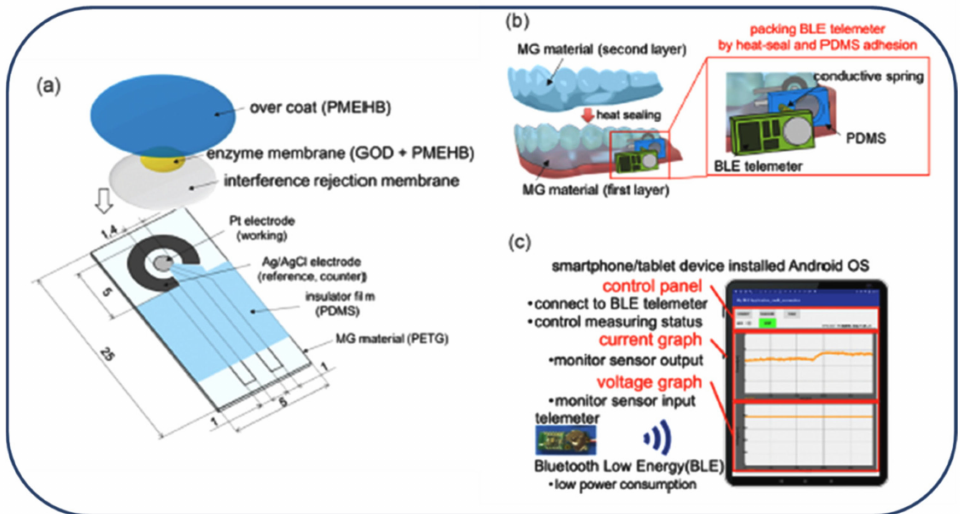
Figure 6. Pictorial display of whole MG glucose sensor and measurement system. ( a ) Electrode fabrication for glucose sensor; ( b ) mounting of MG-type sensor using a conductive spring and PDMS sheet; ( c ) portable wireless detection system using Android tablet devices. Reproduced with permission from Ref.